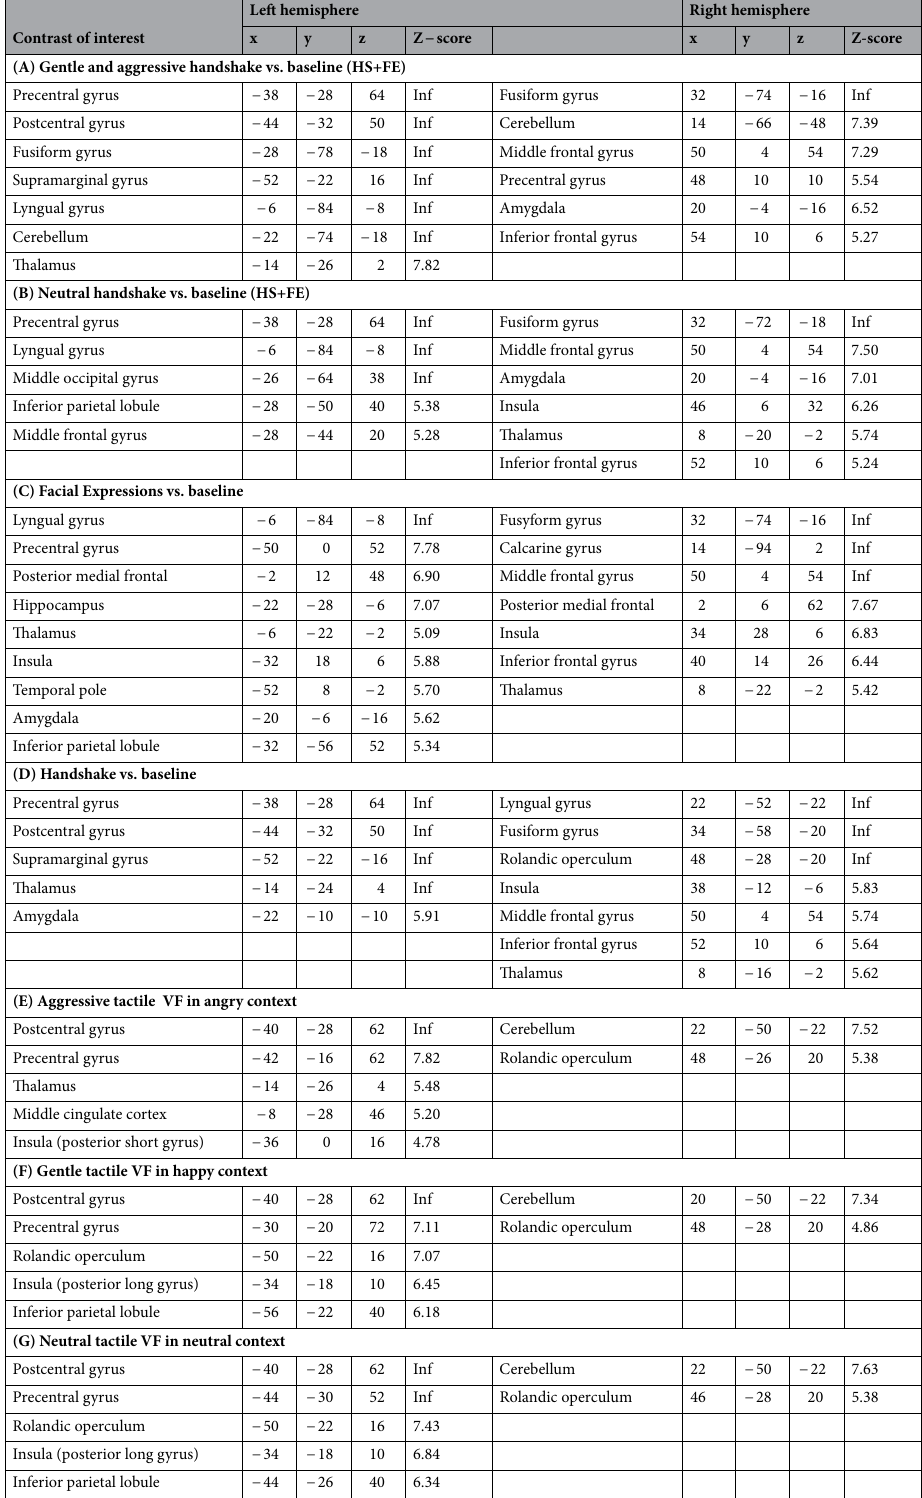
Table 2. Brain activations obtained in Exp. 2 from the three different situations (handshake and facial expression; facial expression; handshake). Activations obtained in the first situation (HS + FE) during the vitality forms (aggressive and gentle) (A) and neutral (B) (control) conditions vs. baseline. Activations obtained in the second (facial expression) (C) and third situations (handshake) (D) vs. baseline. Activation resulting from the following direct contrasts: aggressive vs. facial expressions (E), gentle vs. facial expressions (F), neutral vs. facial expressions (G). Local maxima, as shown in Fig. 4 and Fig. S4, are given in MNI standard brain coordinates, significant threshold was set at P FWE <